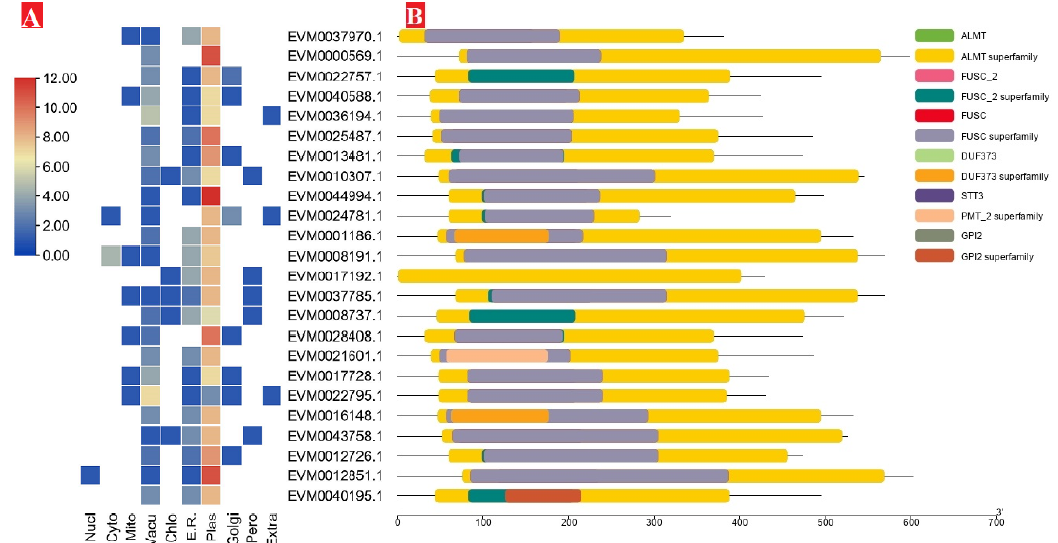
Figure 2. ( A ) Prediction of subcellular localization of EjALMT proteins. Higher signal levels are shown as red, lower signal levels are indicated as blue, while white color indicates no available data. Abbreviations: Nucl–Nucleus; Cyto–Cytonuclear; Mito–Mitochondria; Vacu–vacuole; Chlo–chloroplast; E.R.–endoplasmic reticulum; Plas–plasma membrane; Golgi–golgi apparatus; Pero–peroxisome; Extra–extracellular. ( B ) Conserved domain analysis of ALMT genes in loquat genome.